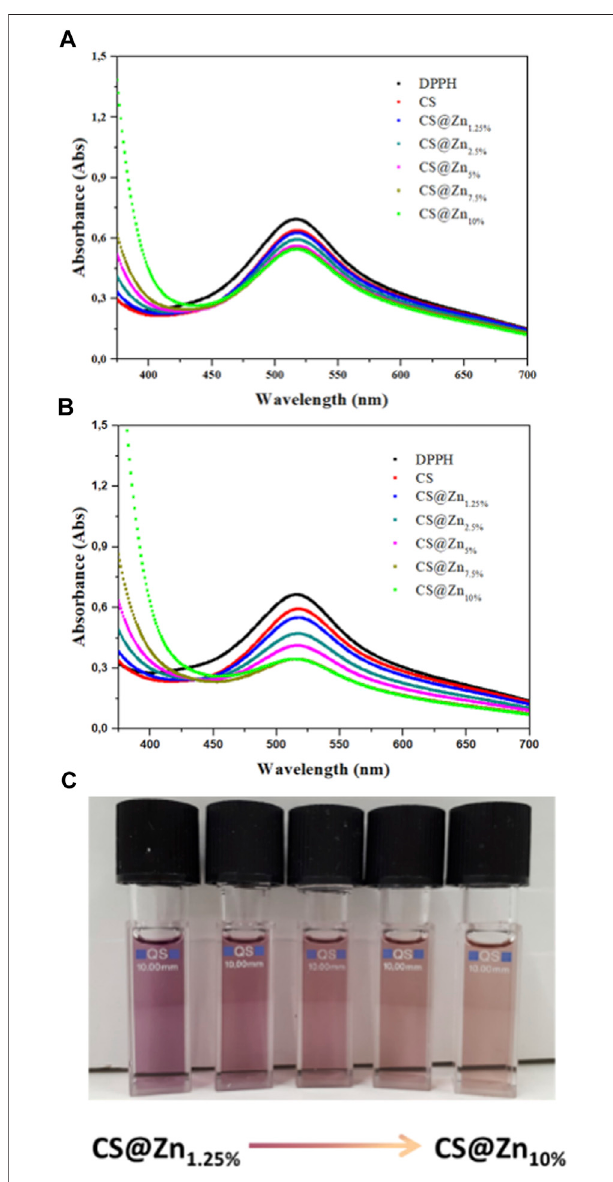
DPPH solution ( Table 1 ). As reported in Table 1 and